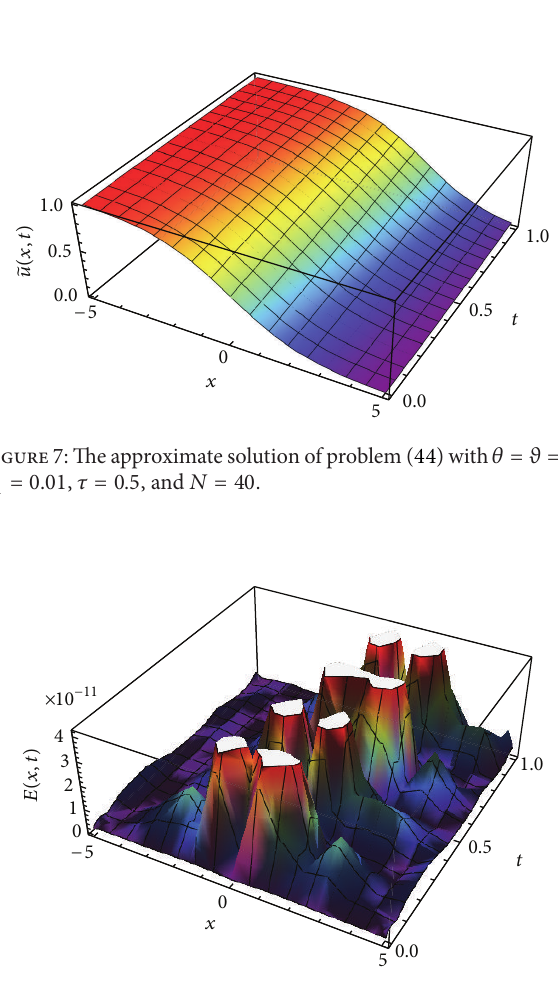
Figure 8: The absolute error between the approximate and the exact solutions of problem (44) with 𝜃 = 𝜗 = 0 , 𝜆 1 = 0.01 , 𝜏 = 0.5 , and 𝑁 = 40